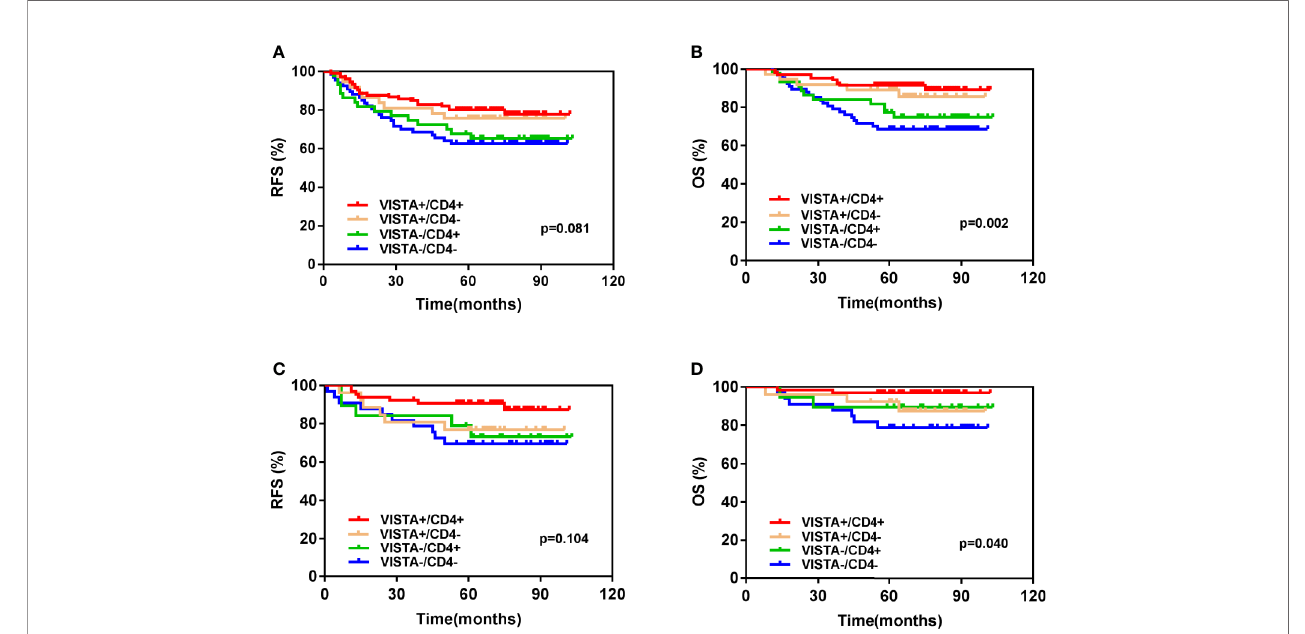
FIGURE 5 | Kaplan-Meier survival analysis based on different immune subtypes according to V-domain Ig suppressor of T cell activation (VISTA) and CD4 of (A) Relapse-free survival (RFS) of the whole cohort. (B) Overall survival (OS) of the whole cohort. (C) RFS of T1-2N0 patients. (D) OS of T1-2N0